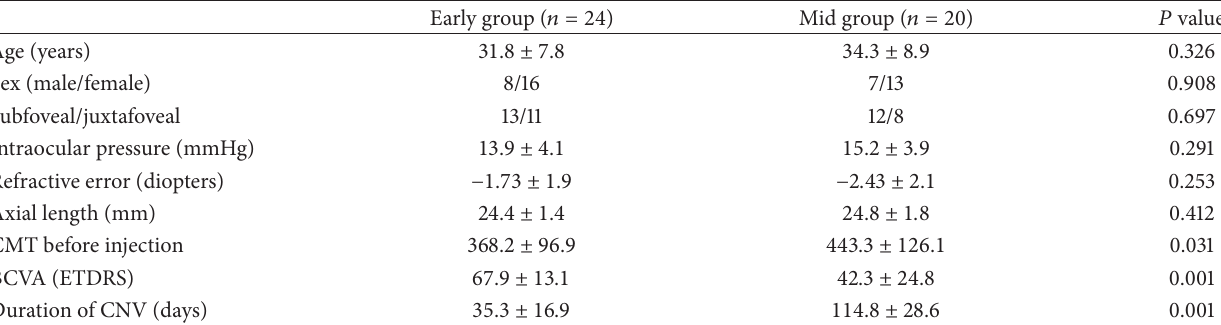
Table 1: A comparison of baseline clinical characteristics.